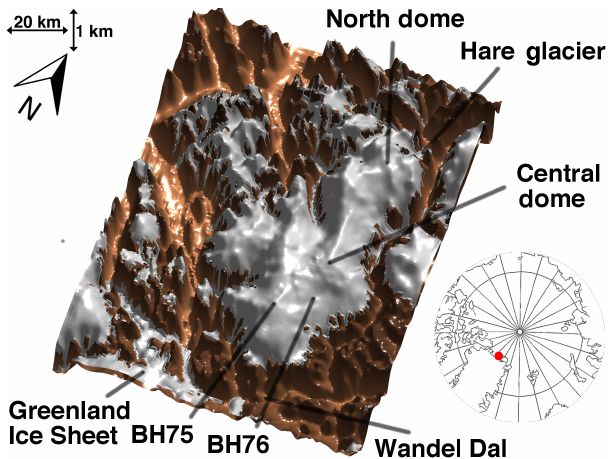
Figure 1. Hans Tausen Iskappe in the mid-1990s. Figure created with the TopoZeko toolbox (Zekollari, 2016). Map in lower right corner shows the location (red dot) of the ice cap in